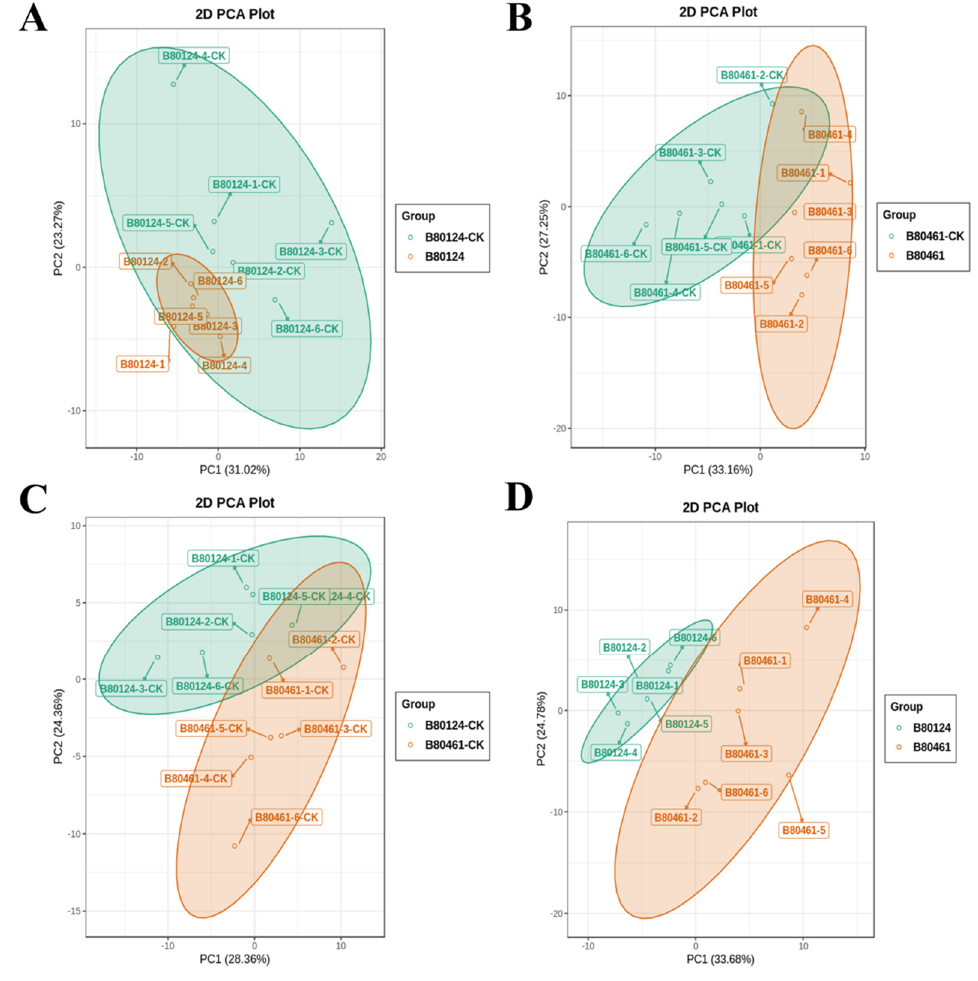
Figure 2. Principal component analysis (PCA) of samples between groups for difference comparison. The four groups were B80124-CK (“-CK” stands for the non-inoculated materials) and B80124 ( A ), B80461-CK and B80461 ( B ), B80124-CK and B80461-CK ( C ), B80124 and B80461 ( D ).